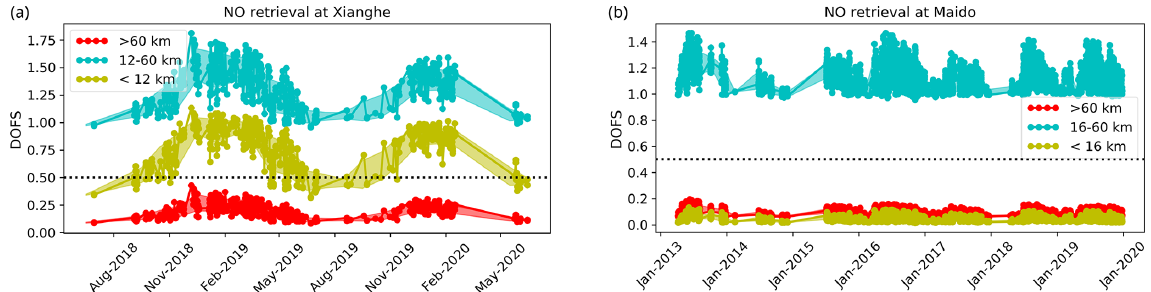
Figure 4. The series of the DOF daily mean (dots) and the SD (shadow) in the troposphere, stratosphere, and above at Xianghe (a) and Maïdo (b) . The dashed black line is at DOF of